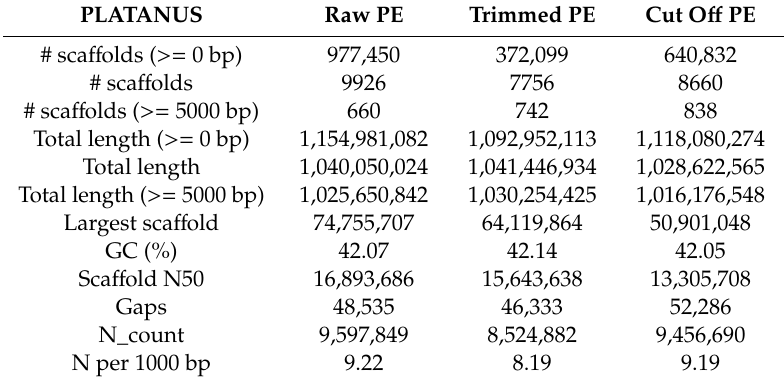
Table 1. De novo assembly results of rufous-capped babbler genomes based on three datasets using PLATANUS. The summaries are based on sca ff olds ≥ 1000 bp, with exceptions noted in the rows. PLATANUS